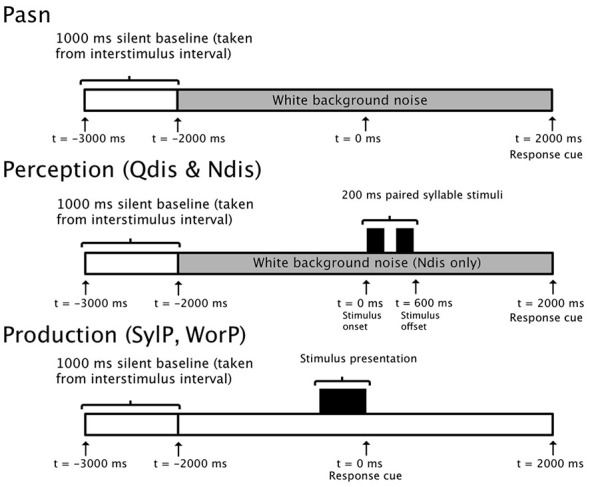
5000 ms epoch timelines for single trials in control (PasN), discrimination (Qdis and Ndis), and production (SylP and WorP) conditions.